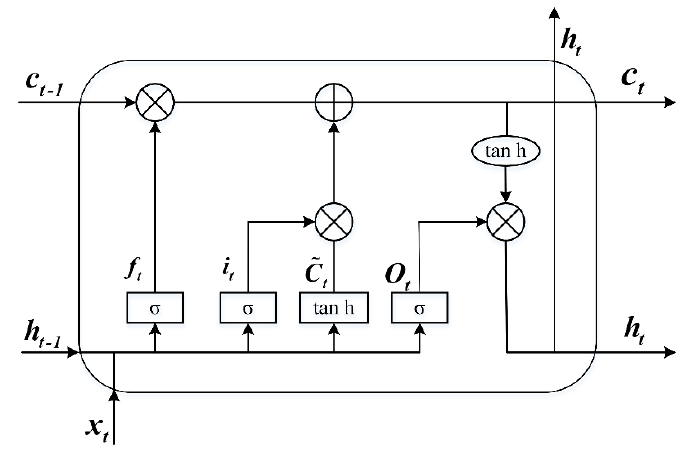
Figure 3. Network deployment structure of LSTM.